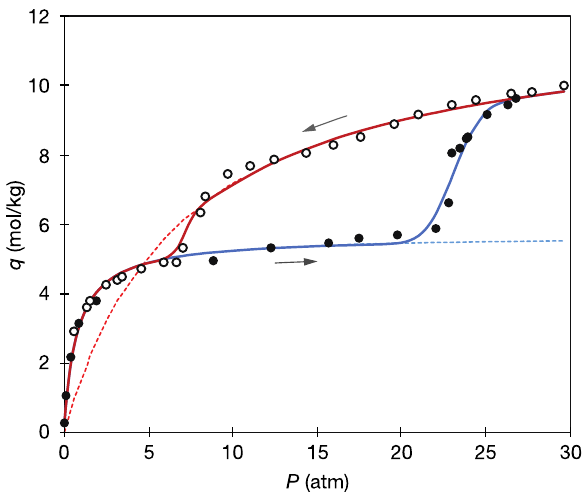
Figure 8. Fitting of the osmotic thermodynamic theory to the adsorption ( ● ) and desorption ( ○ ) branches of the experimental CO 2 isotherm at 273 K. Dashed lines: fitted Langmuir adsorption isotherms if the framework were rigid and constrained to its EP (– – –) and SP (– – –) forms; solid lines: predicted adsorption (——) and desorption (——) branches of the isotherm at 273